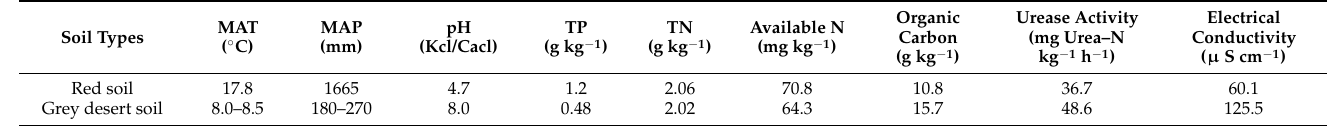
Table 1. Physical and chemical properties of the soils used for this